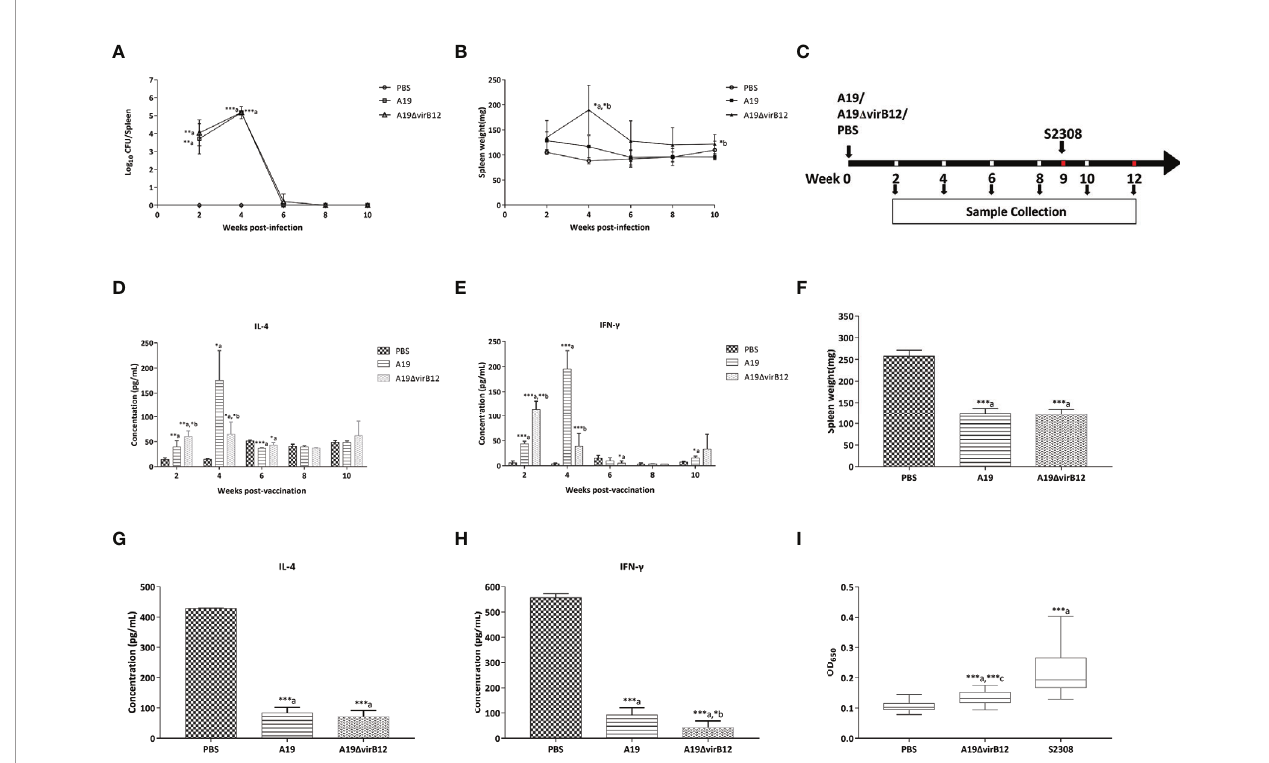
FIGURE 1 | Characteristics of A19 D virB12 vaccination. To determine the virulence of A19 D virB12, female BALB/c mice were i.p. injected with 5 × 10 5 CFU of A19 D virB12, A19, or PBS. Colonization levels (A) and spleen weights (B) were assessed at 2, 4, 6, 8, and 10 weeks post-infection. To determine the protective ef fi cacy of immunization with A19 D virB12, female BALB/c mice were immunized i.p. with 5 × 10 5 CFU of A19 D virB12 or A19 while the control group received 0.2 ml of PBS (C) . At 9 weeks post-vaccination, mice (n=5 per group) were challenged with 5 × 10 5 CFU of virulent S2308 (C) . The levels of IL-4 (D) and IFN- g (E) were measured at 2, 4, 6, 8, and 10 weeks post-vaccination. At 3 weeks post-challenge, the spleen weight (F) , and the levels of IL-4 (G) and IFN- g (H) were measured. Immune response of VirB12 to A19 D virB12-immunized sera and challenged sera was shown in the (I) . Values was expressed as the means ± standard deviation (SD). Differences were determined by the two-tailed Student's t test or Mann-Whitney U test. The letter a in the (A – I) indicates statistically signi fi cant differences between A19 or A19 D virB12 and the PBS group; The letter b in the (A – H) indicates statistically signi fi cant differences between A19 and A19 D virB12; The letter c in the (I) indicates statistically signi fi cant differences between A19 D virB12 and S2308 (*P < 0.05; **P < 0.01; ***P <